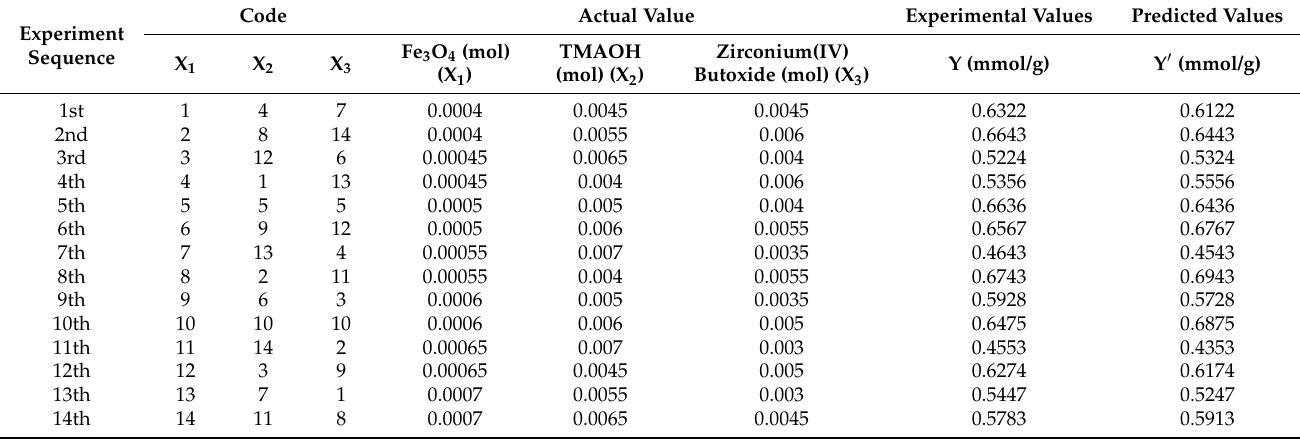
Table 4. Arrangements of uniform design and test